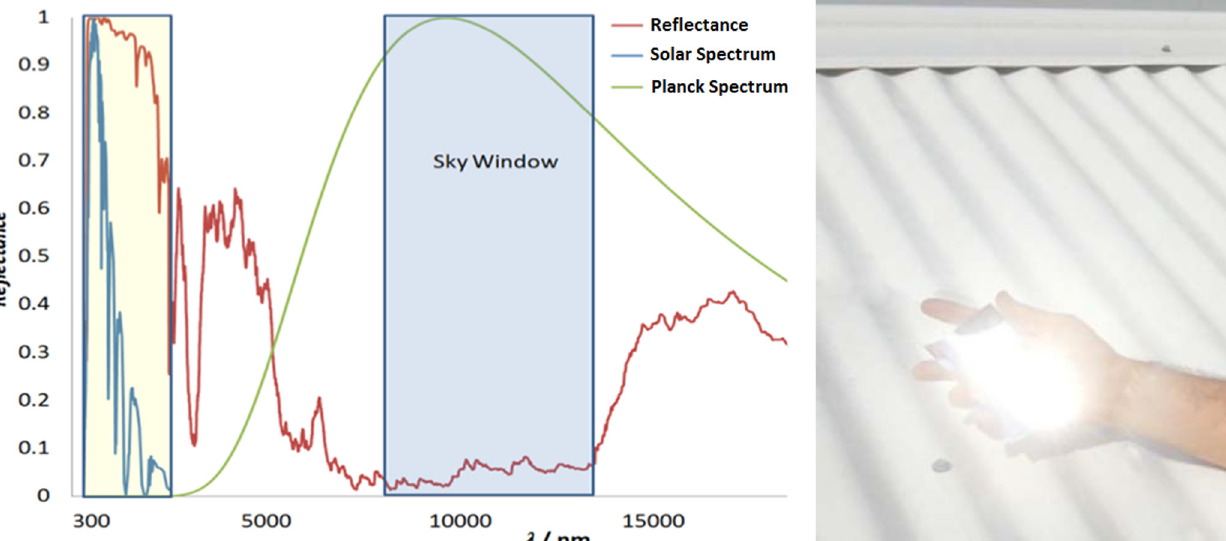
Fig. 3. The re fl ectance spectrum (red) of our super-cool material across the solar and thermal radiation spectral ranges. Superimposed (scaled to their maximum values) for reference are the AM1.5 solar intensity spectrum (blue) and the Planck black body spectrum (green). R sol is 97%, and emittance is very high within the clear sky transparent zone, which is shown shaded. The right image shows this surface in summer sunlight above a white commercial cool roof.